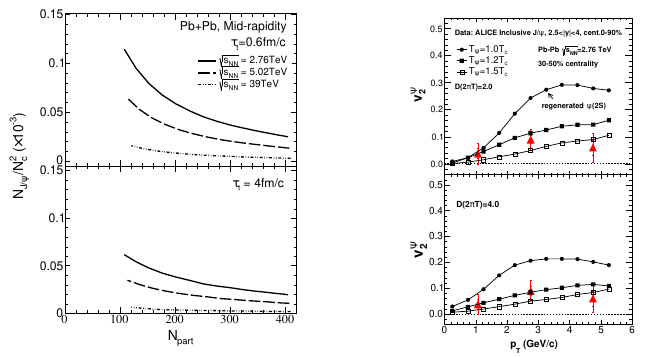
Figure 4. The left panel is N J /ψ / ( N c ) 2 as a function of number of participants N p with the assumption of charm quark reaching kinetic equilibrium at di ff erent time τ f , here N c represents equals the number of all charmed particles. The right panel is the elliptic flow of regenerated charmonia at di ff erent temperature. It is simulated by the Langevin equation. These figures are cited from [19,